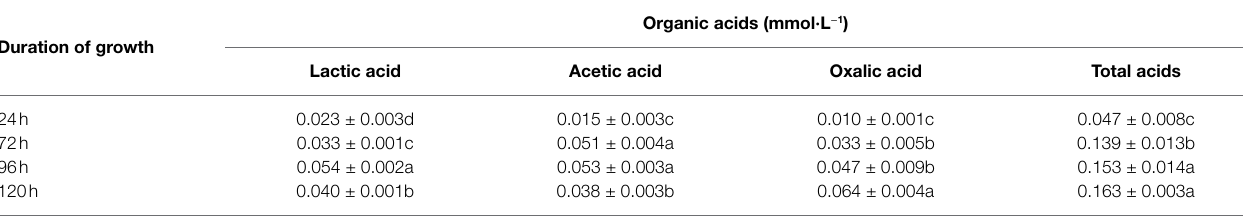
TABLE 1 | Organic acids in the Penicillium oxalicum F9 culture medium.